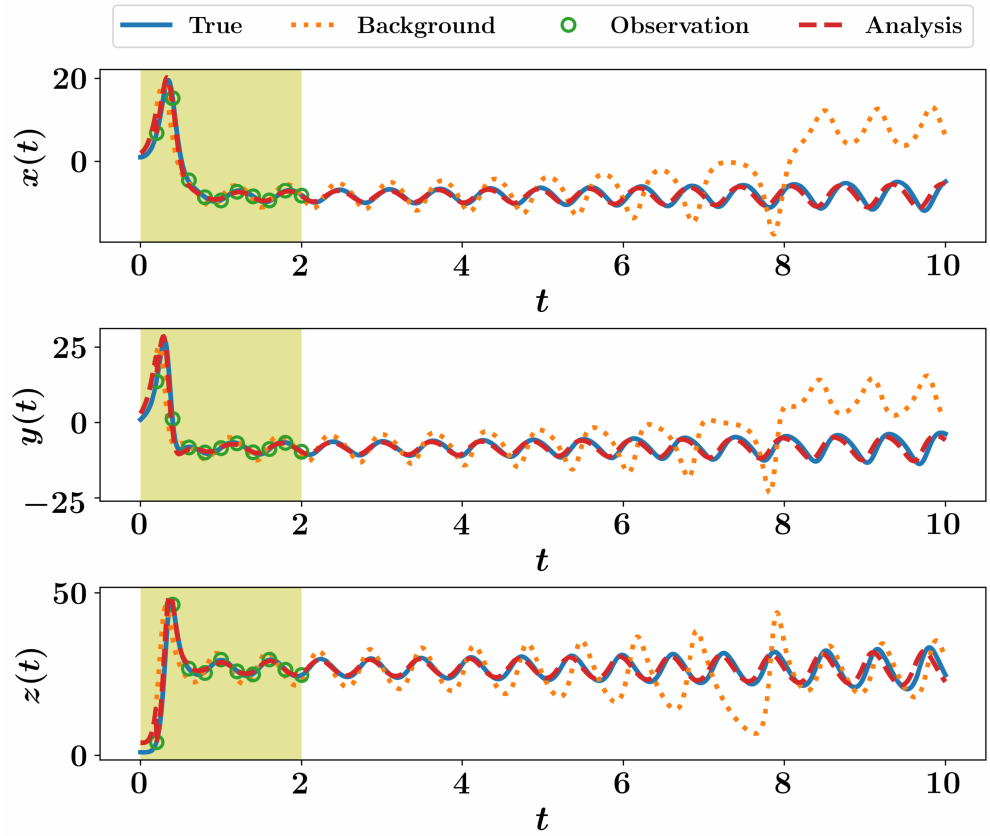
Figure 6. DEnKF results for the Lorenz 63 system without virtual